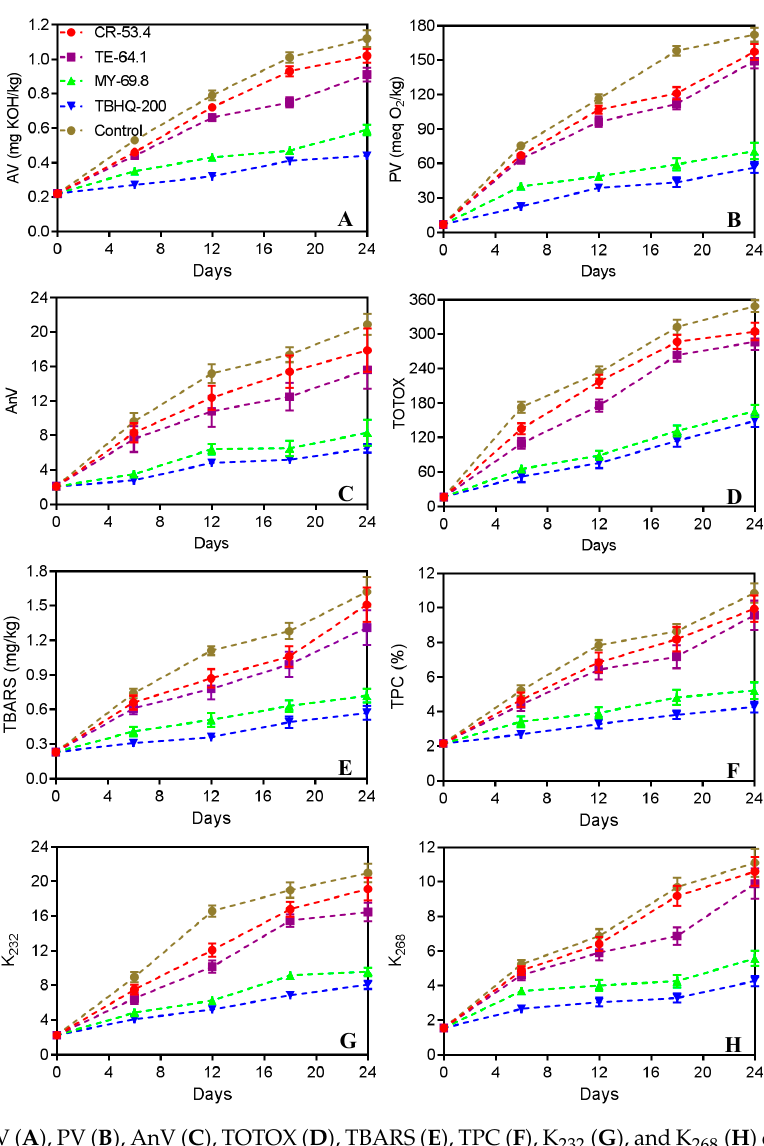
Figure 3. AV ( A ), PV ( B ), AnV ( C ), TOTOX ( D ), TBARS ( E ), TPC ( F ), K 232 ( G ), and K 268 ( H ) of sunflower oil samples during high-temperature storage influenced of myrcene, terpinen-4-ol, and cryptone.